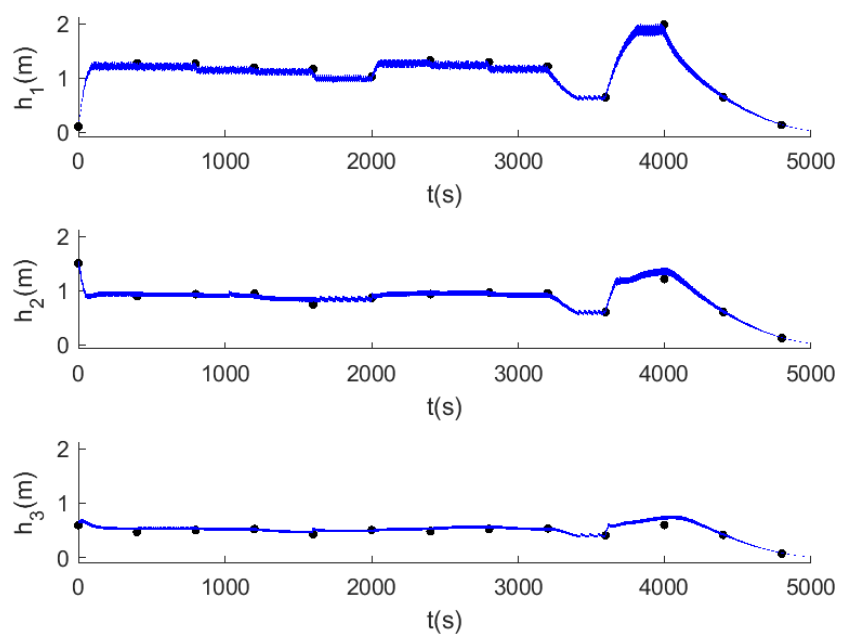
Figure 9. Three-tank system. Simulation results for the open loop control of the liquid heights.